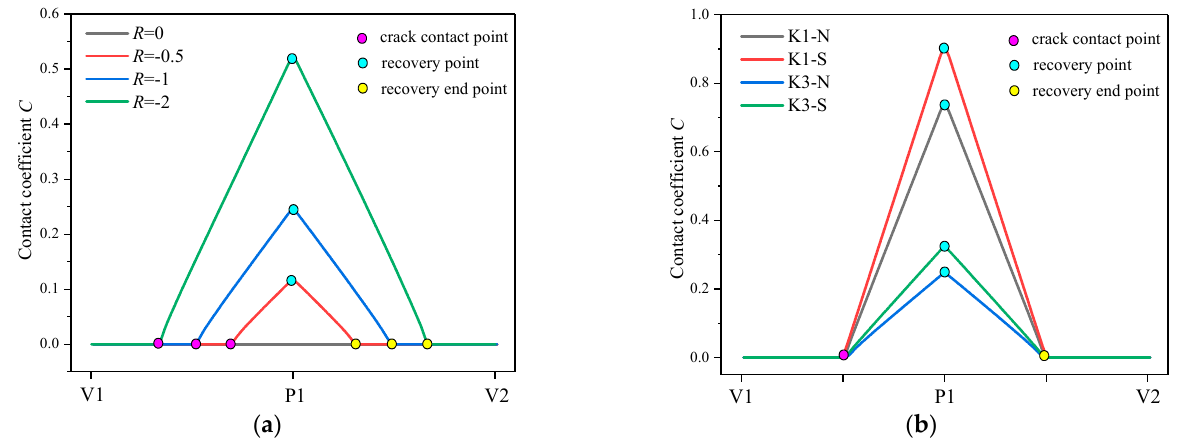
Figure 7. Regulations of contact coefficients C : ( a ) effect of loading ratio R , ( b ) effect of specimen type. The contact coefficient C proposed in the paper is the quantification of contact